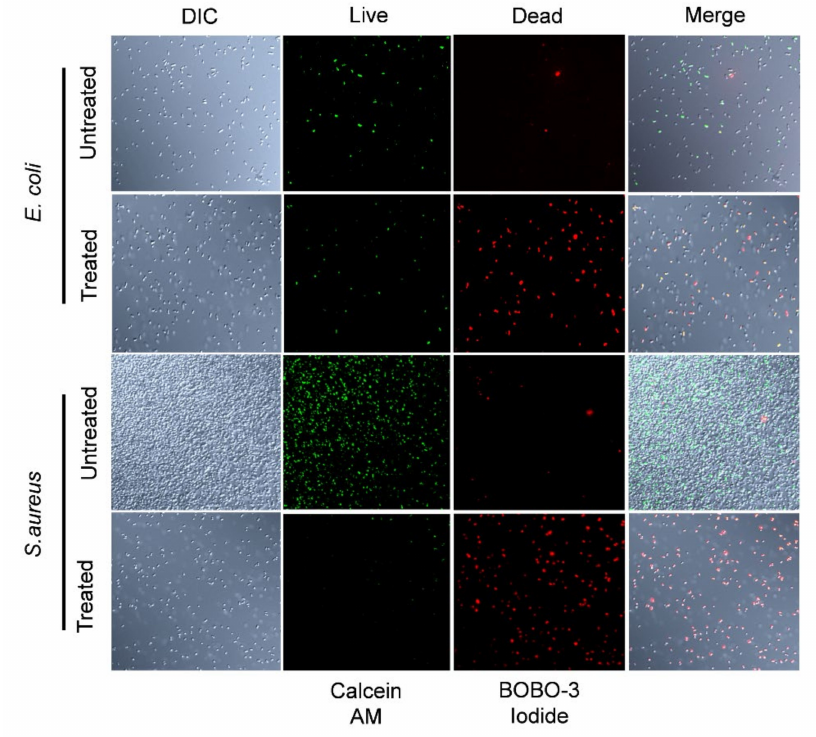
Figure 5. Bacterial cell integrity was compromised after PG-NOW treatment. Confocal laser scanning microscopy images show the live and dead cells of E. coli and S. aureus following PG-NOW treatment at 1000 µ M concentration and stained with calcein AM (green fluorescence) and BOBO-3 iodide (red fluorescence), which indicates a compromised cell membrane. DIC: Differential Interference